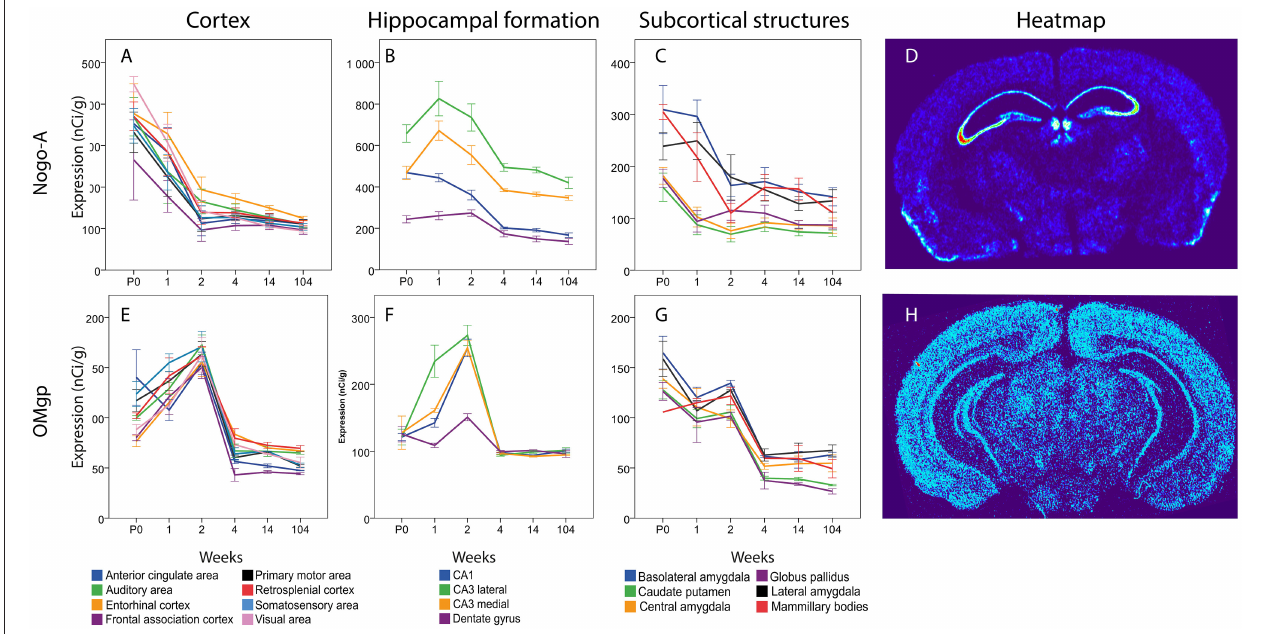
FIGURE 11 | Graphs showing expression levels of mRNA encoding Nogo-A (A–C) and OMgp (E–G) in 18 cerebral regions over time. For full legend see Figure 9. Heatmaps of the two genes (D,H) visualizing expression in 14 week old mice.